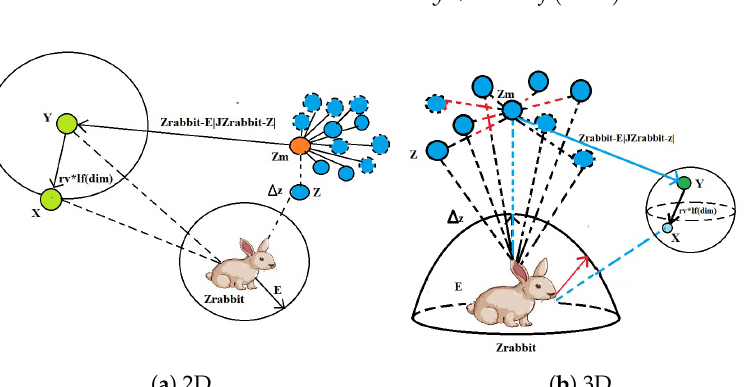
Figure 7. In the circumstance of a hard besiege with progressive speedy dives in 2D and 3D dimension, an example of overall vectors.